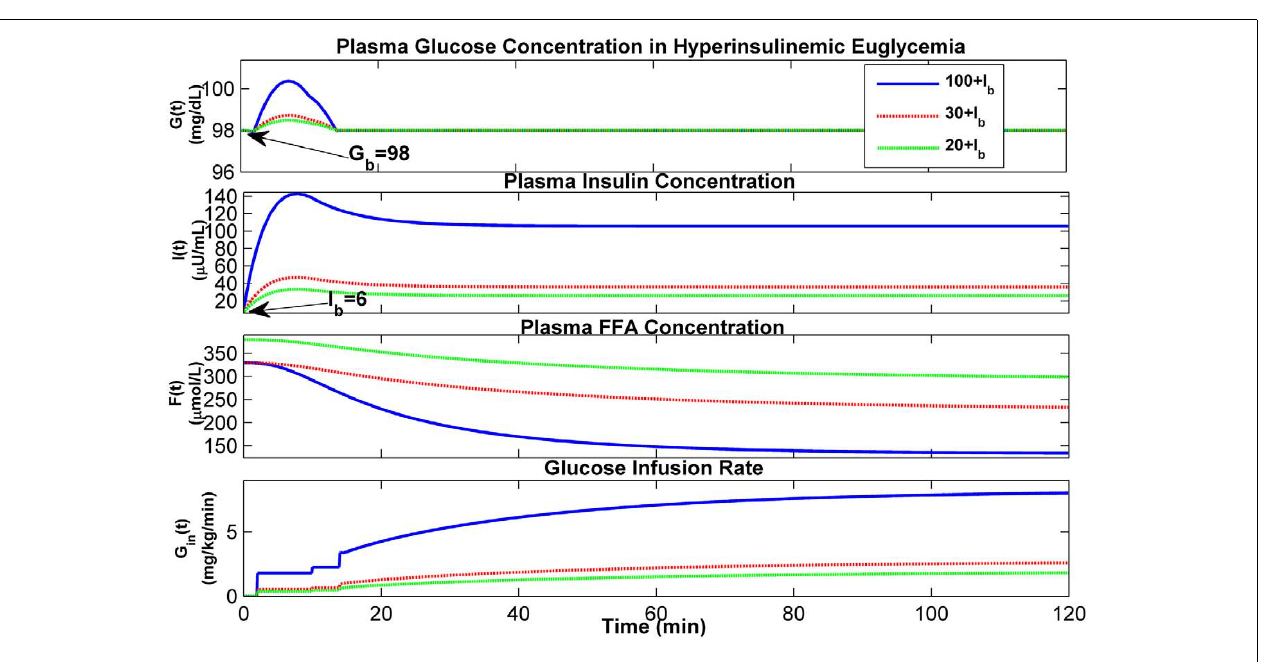
both normal and OSA subject and during both wakefulness and sleep, as well as in the epinephrine level from its control corre- sponding to the change of α -sympathetic activity. Also, as might be expected, the analysis shows that the gain ( K ce,0 ) for basal level of epinephrine is the most sensitive parameter for epinephrine regulation in